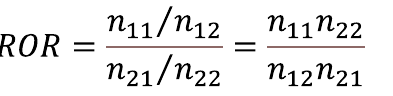
Figure 7. Cross-tabulation and formula for the ROR of hiccups. The cross-tabulation is structured